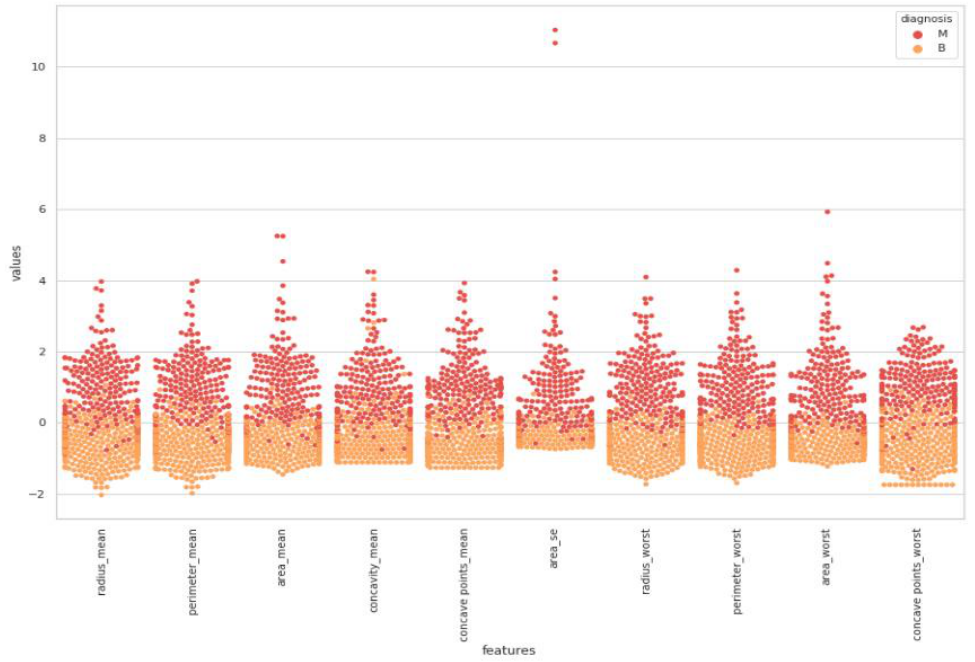
Figure 8. Final swarm plot after second elimination.